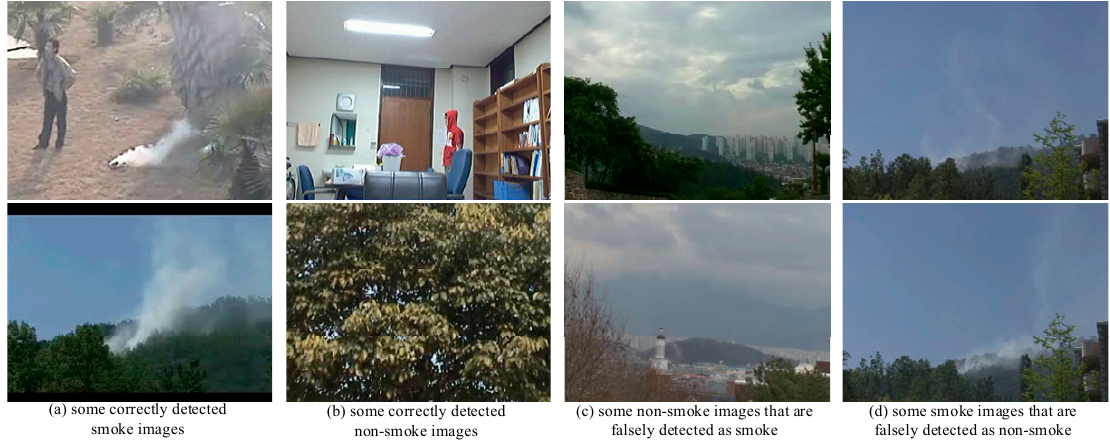
Figure 8. Some detection results.